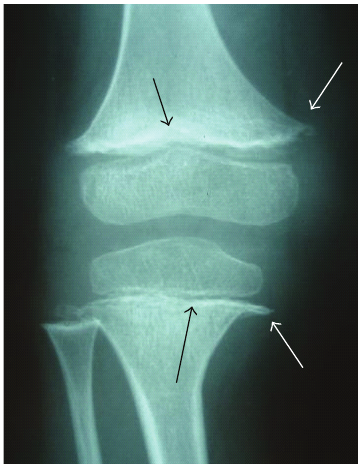
Figure 1: Anterior-posterior radiograph of the knee showing osteopenia, a thickened white line at the metaphysis of both femurs and tibiae (black arrow) and a small beak-like excrescences at the metaphysic of femur and tibi (white arrows).